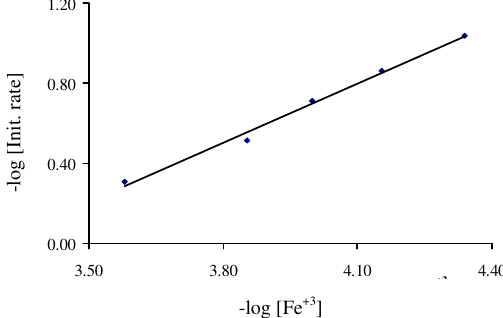
Figure 6. Plot of log [Initial rate] vs . log [Fe 3+ ] at λ [Fe 3+ ] = 0.15-2 x 10 -4 M, [Cysteine] = 2 x 10 -4 M, 10% ethanol and pH =